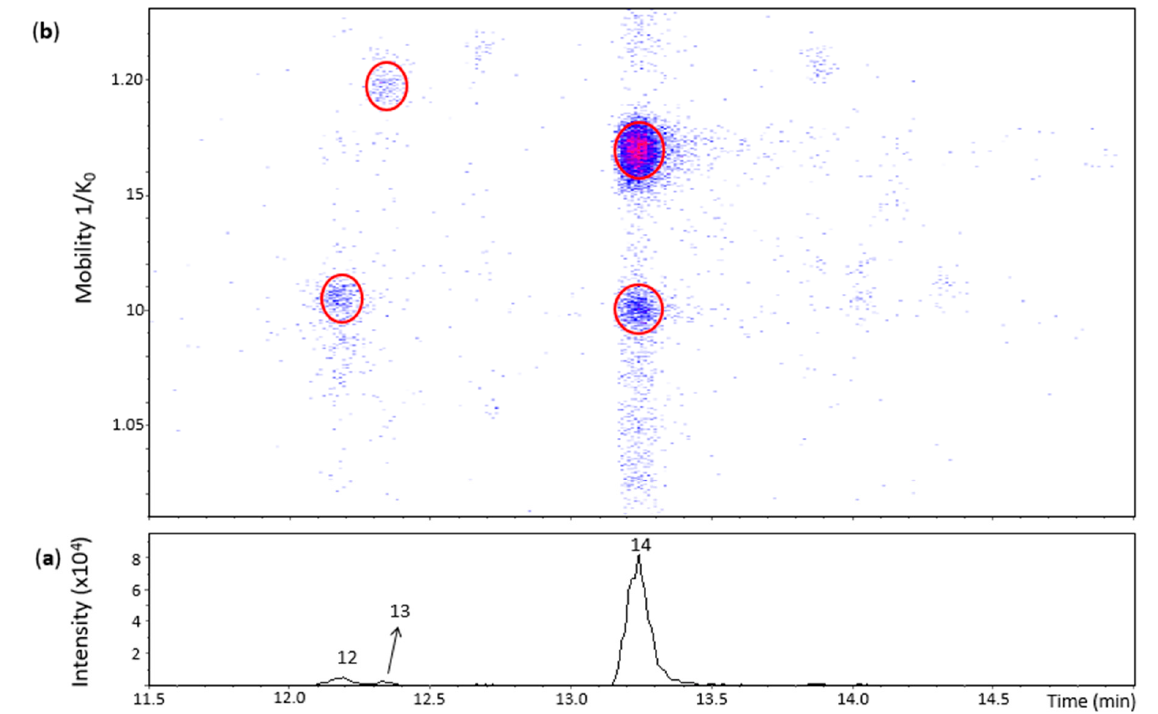
Figure 3. UHPLC − ESI ( − ) − TIMS − QTOF − MS/MS analysis of dehydrodicatechins in model solution containing (+)-catechin and grape PPO extract. ( a ) EIC from the mass range of m / z 575.1–575.2; ( b ) heat map showing the mobility versus Rt for the mass range of m / z 575.1–575.2. Full details on peak numbers are available in Table S2. Ellipses on the heat map mark the main spots.